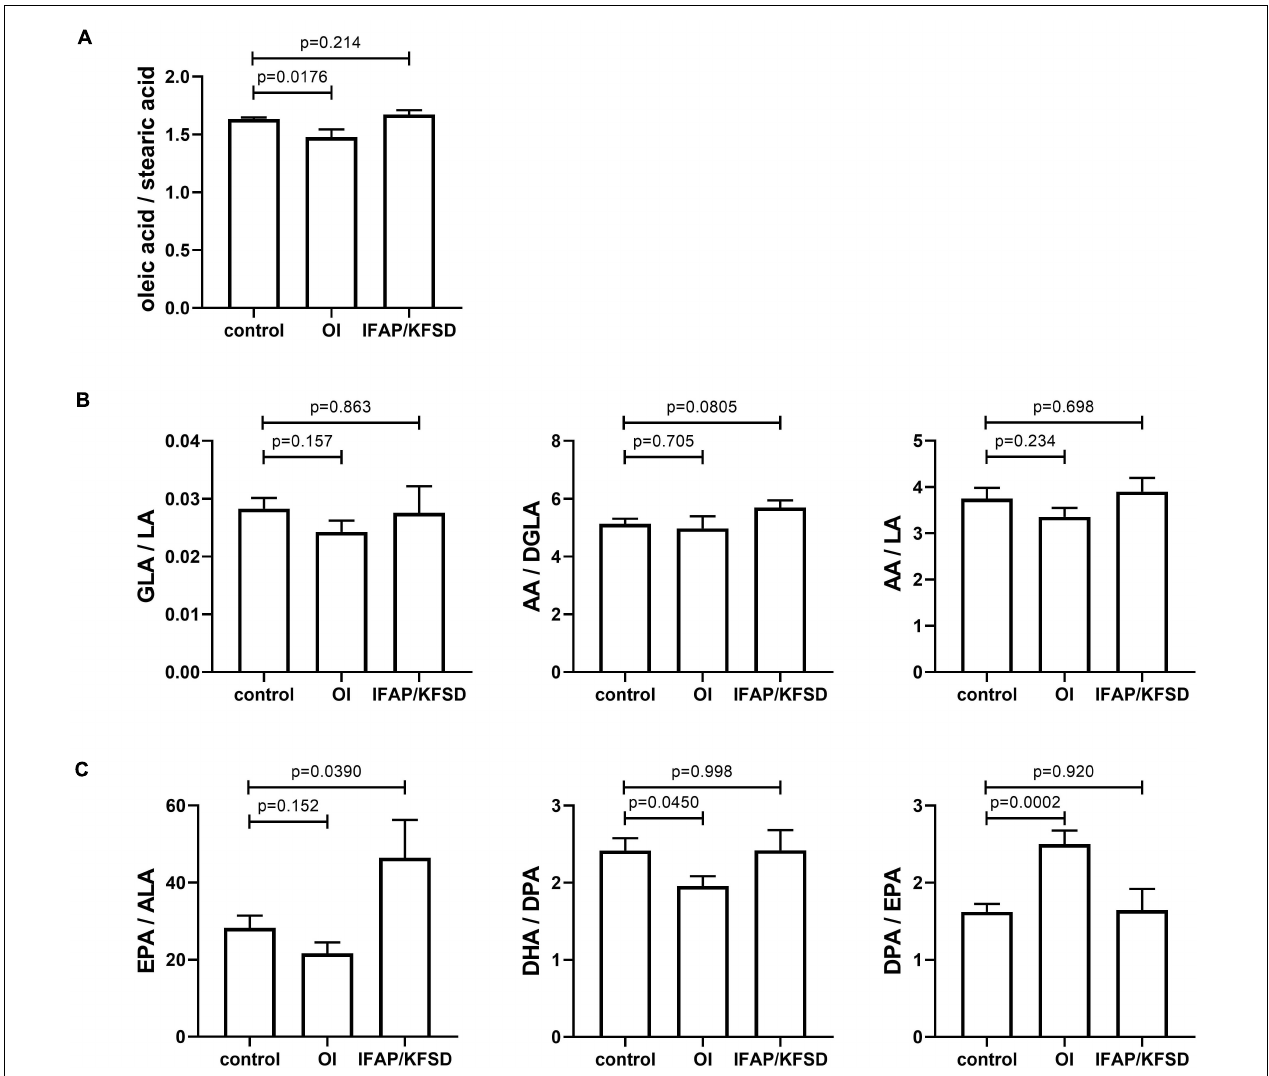
FIGURE 11 | (A − C) The cellular content of several saturated, monounsaturated and polyunsaturated omega-6 and omega-3 fatty acids were determined by GC-MS/MS and expressed as ratios. Four independent measurements were performed per subject, and t -tests were performed for statistical analysis. Data are expressed as mean ±